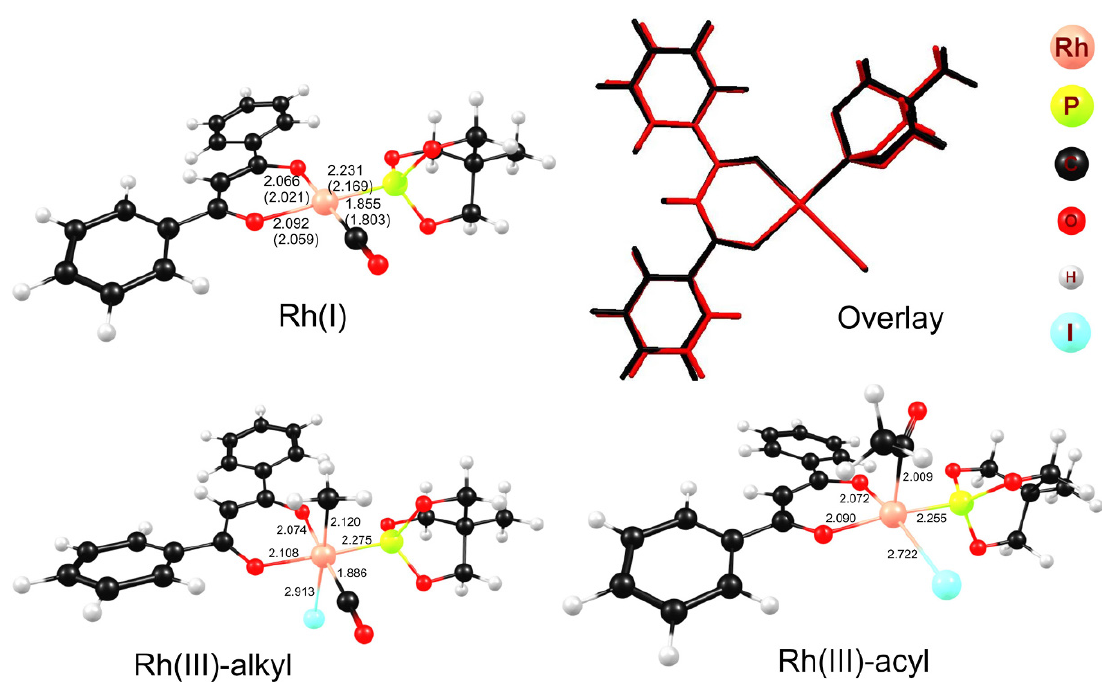
Figure 5. DFT optimized structure of the reactant [Rh(PhCOCHCOPh)(CO)(P(OCH (red) [Rh(PhCOCHCOPh)(CO)(P(OCH [Rh(PhCOCHCOPh)(P(OCH atoms are as indicated. Experimental bond lengths are in brackets. (not shown in Fig. 2) corresponds to the rate constant for